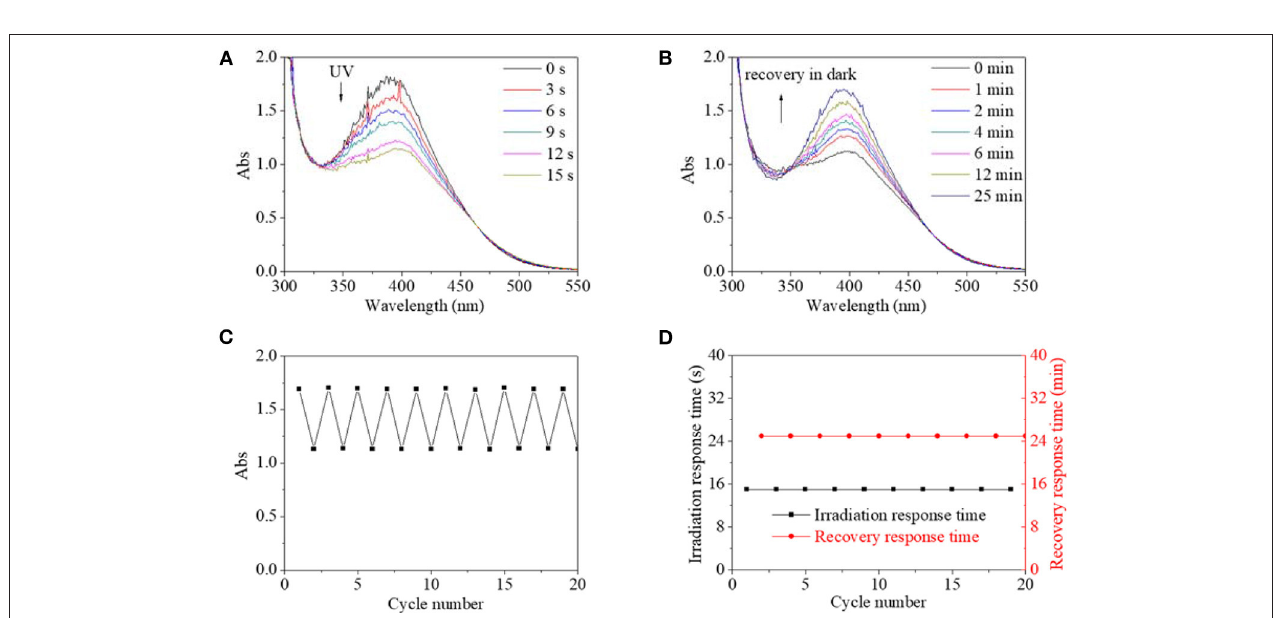
FIGURE 5 | UV spectra of PBLG1 DMF solution as a function of irradiation time (A) and recovery time (B) . (C) Absorbance at 390/400nm of PBLG1 DMF solution as a function of cycle number. (D) Irradiation response time and recovery response time as a function of cycle number. Irradiation was performed under UV light, and the recovery process was performed under darkness and room temperature. Polymer concentration was 17 mg/mL.